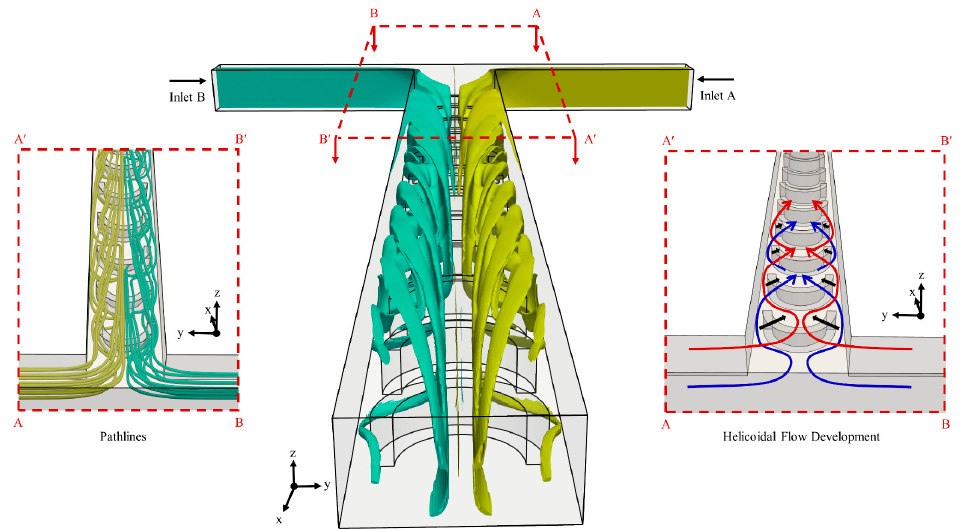
Figure 8. Helicoidal fluid flow in the mixing channel at Re = 40. Yellow and green colors show fluids injected from inlet A and inlet B respectively. Fluids, travelling in the lower and upper height of the inlet channel, are represented by blue and red curvy arrows respectively.